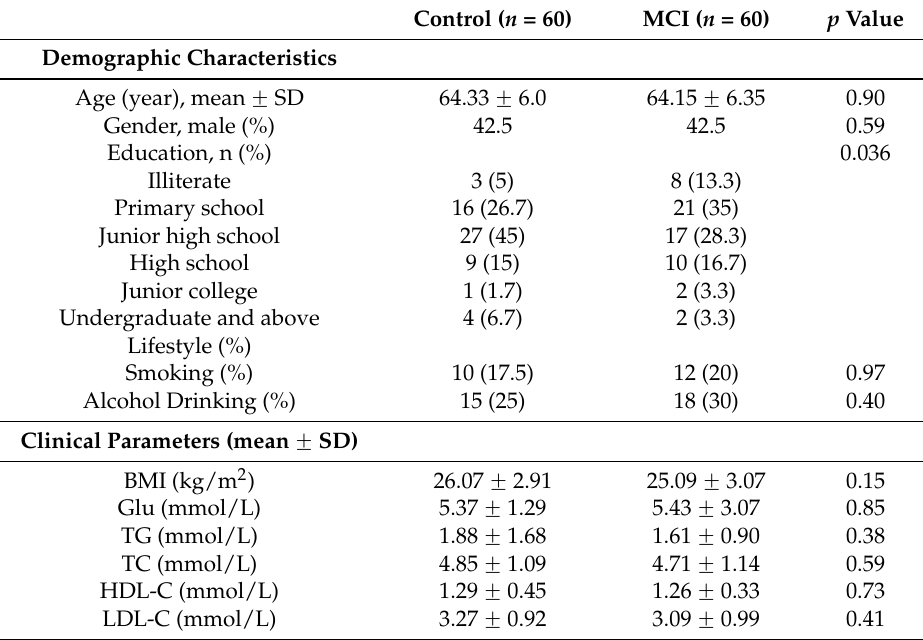
Table 1. Demographics, lifestyle characteristics, and clinical parameters of the participants.